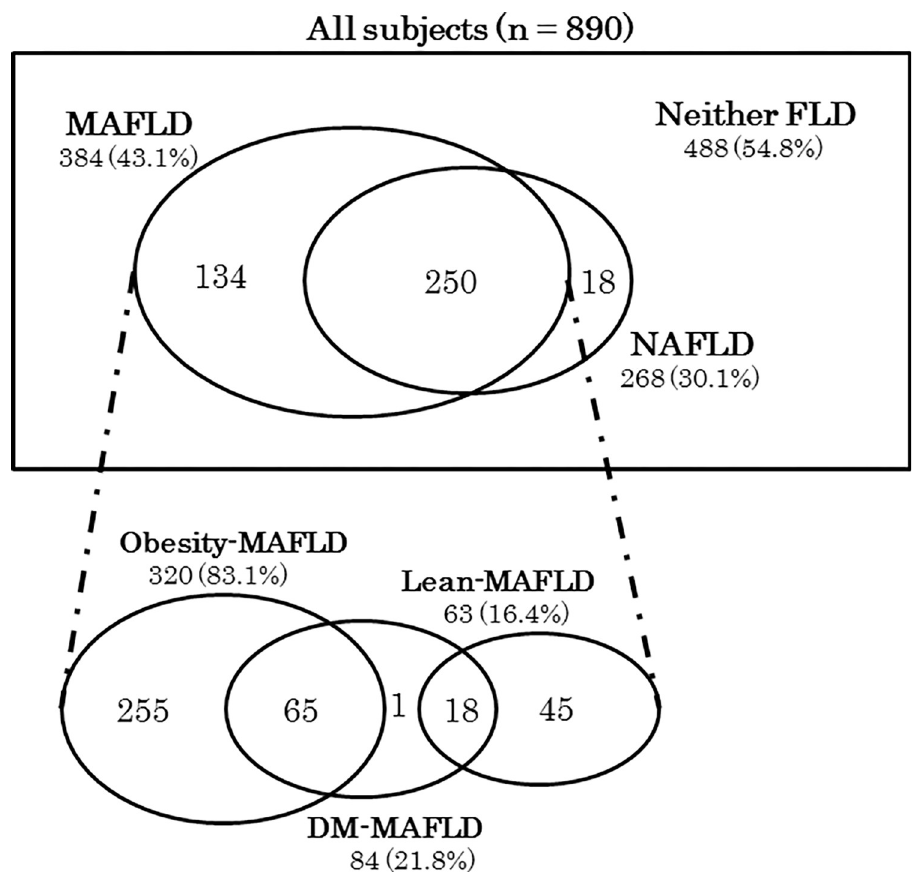
Fig 1. (Upper) The proportion of MAFLD and NAFLD according to the two definitions in the study population. (Lower) The proportion of each of the MAFLD groups. MAFLD, metabolic dysfunction-associated fatty liver disease; NAFLD, non-alcoholic fatty liver disease; DM, diabetes